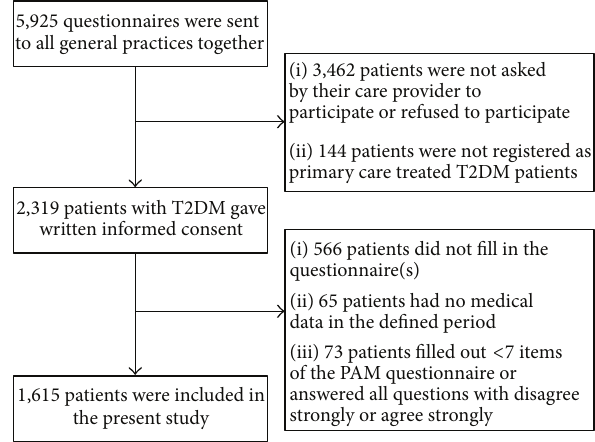
Figure 1: Flowchart of